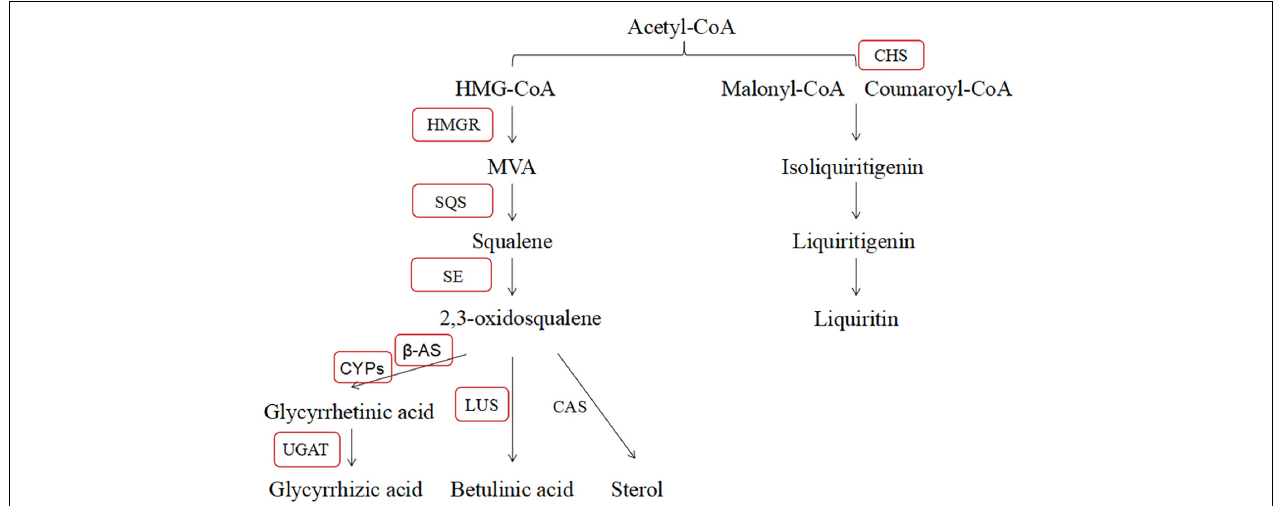
FIGURE 10 | Glycyrrhizic acid and liquiritin biosynthesis pathway.